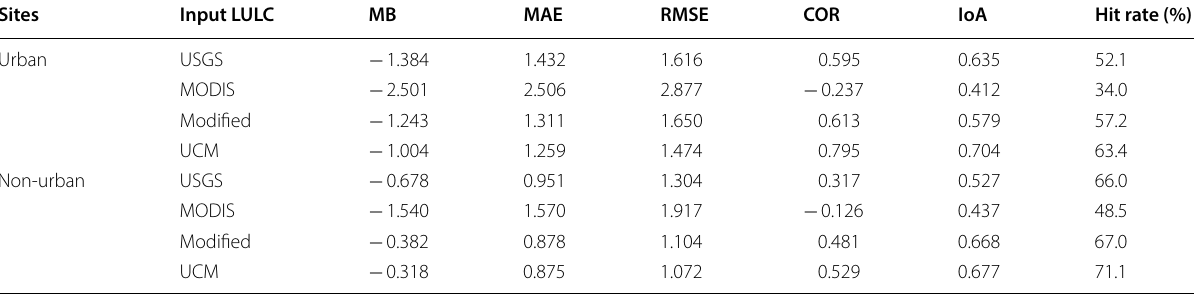
Table 4 Statistical evaluation of maximum UHI for urban and non-urban sites Sites Input